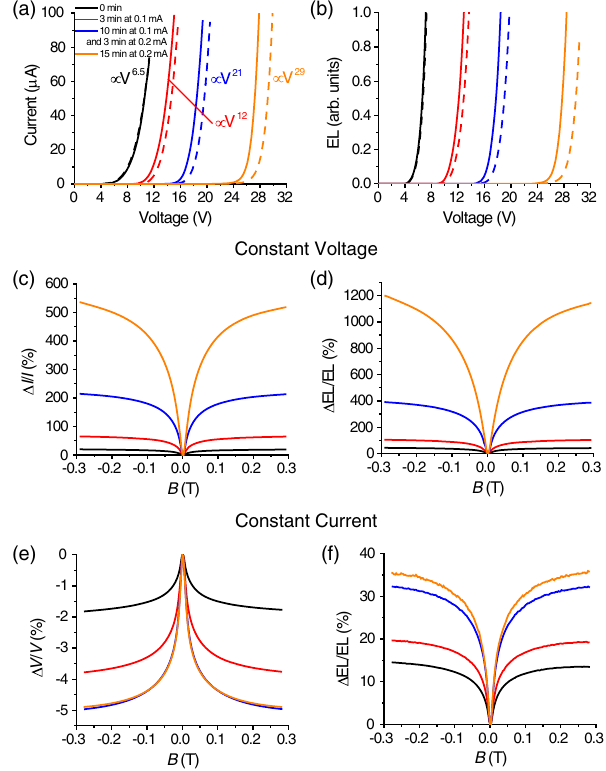
FIG. 8. (a) Current-voltage and (b) electroluminescence- voltage curves for different stages of device conditioning [protocols of the conditioning are specified as labels to the curves of (a); other panels use same color coding]. Dashed (solid) lines are measurements at B ¼ 0 (0.3) T. (c),(d) Constant-voltage and (e),(f) constant-current magnetic-field effect measurements for varying device